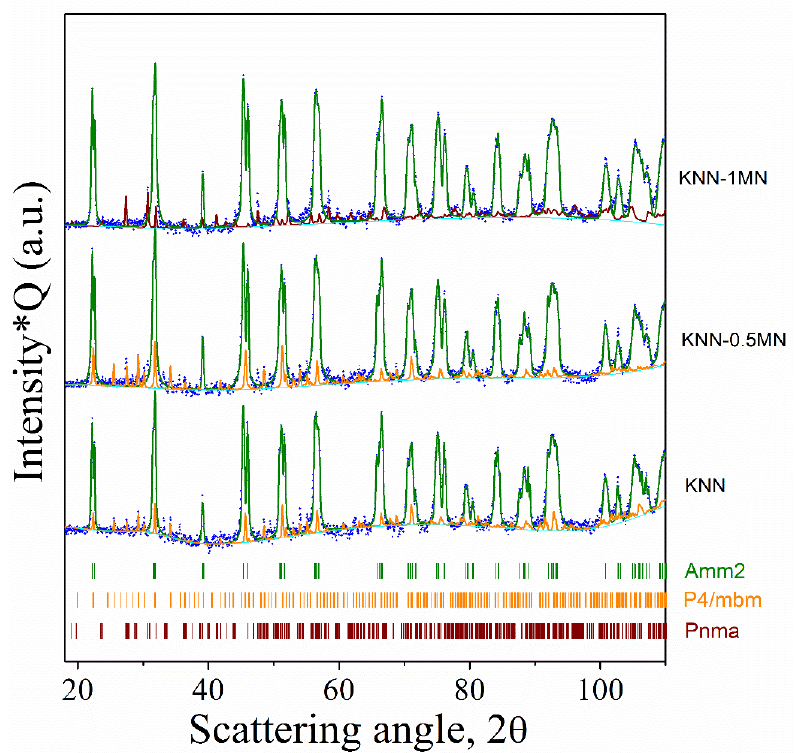
Figure 6. XRD patterns of KNN-xMN sintered pellets.